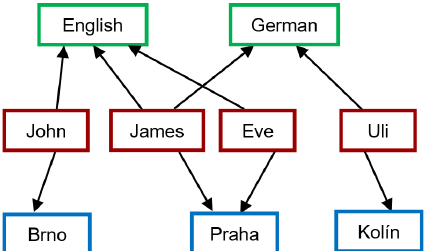
Fig. 1: A graph database.